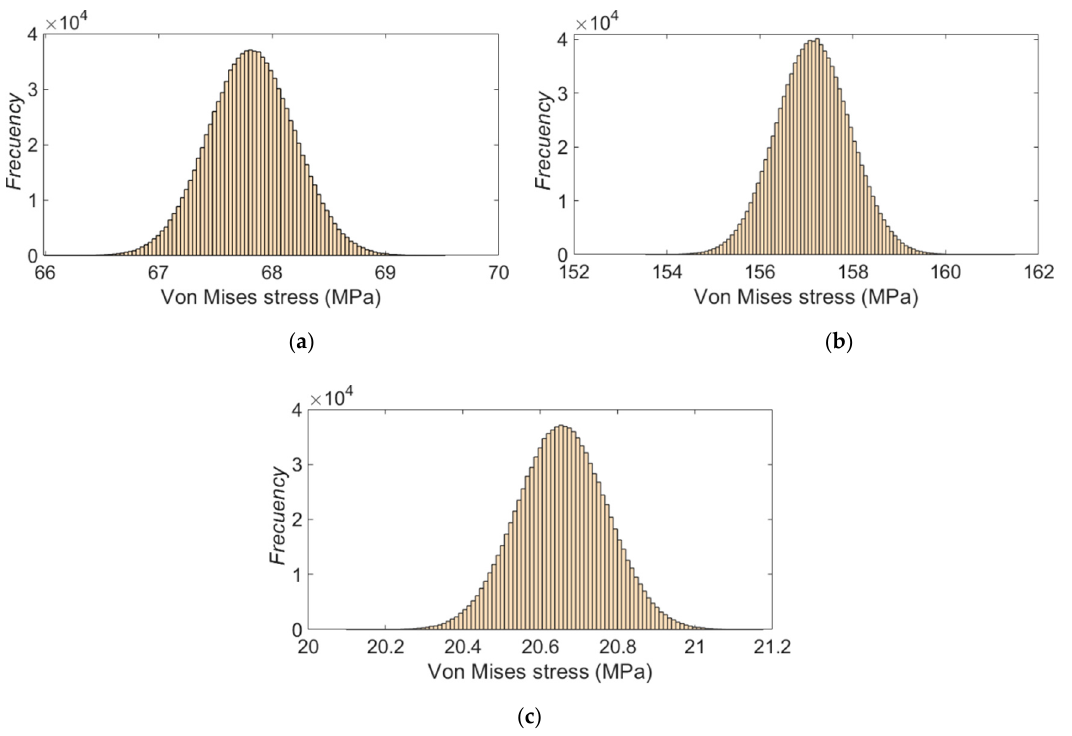
Figure 14. Experimental stress distribution for the strain gauge rosette: ( a ) #1, ( b ) #2 and ( c ) #3.